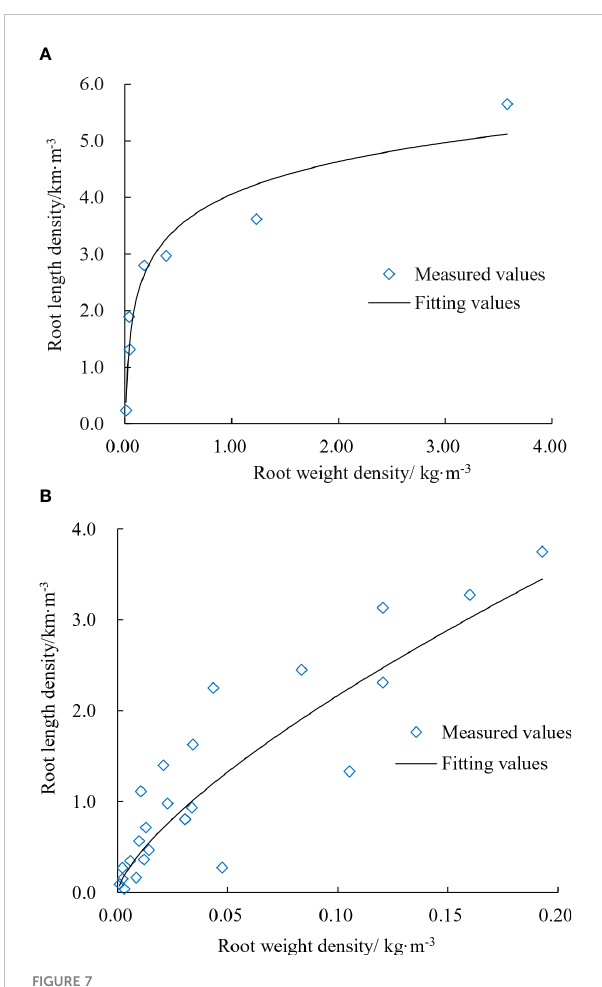
FIGURE 7 Fitting relationship of root density. (A) Root axis location. (B) Other locations.